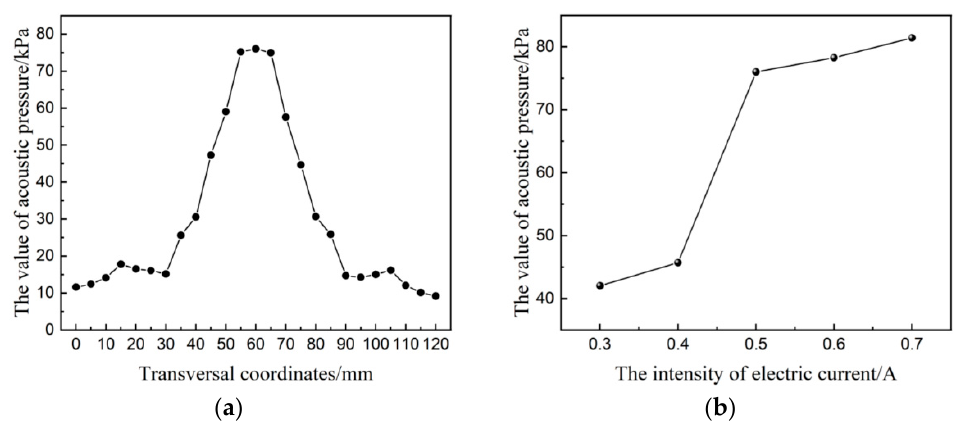
Figure 4. Acoustic pressure detection curve. ( a ) Through focal point transversal. ( b ) Focal point acoustic pressure curve with current.